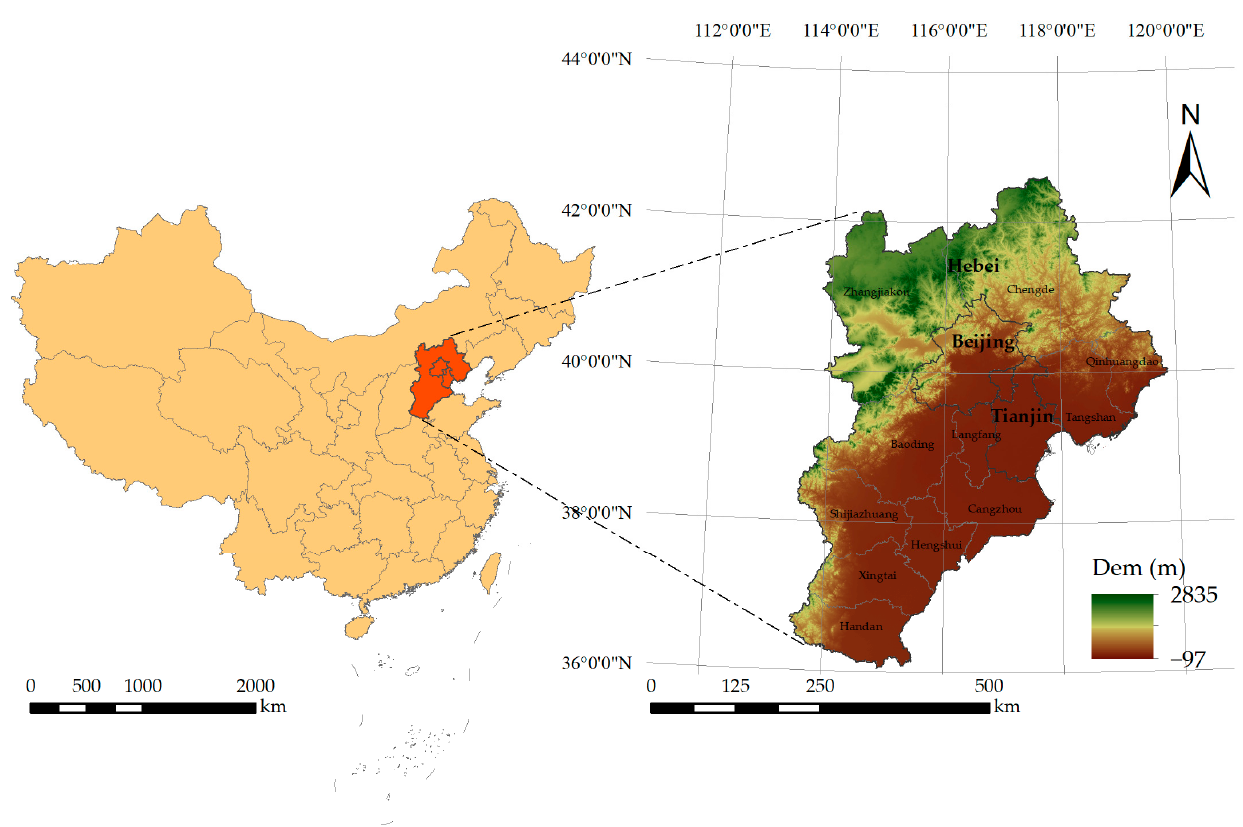
Figure 1. The geographical location and elevation map of the BTH region.